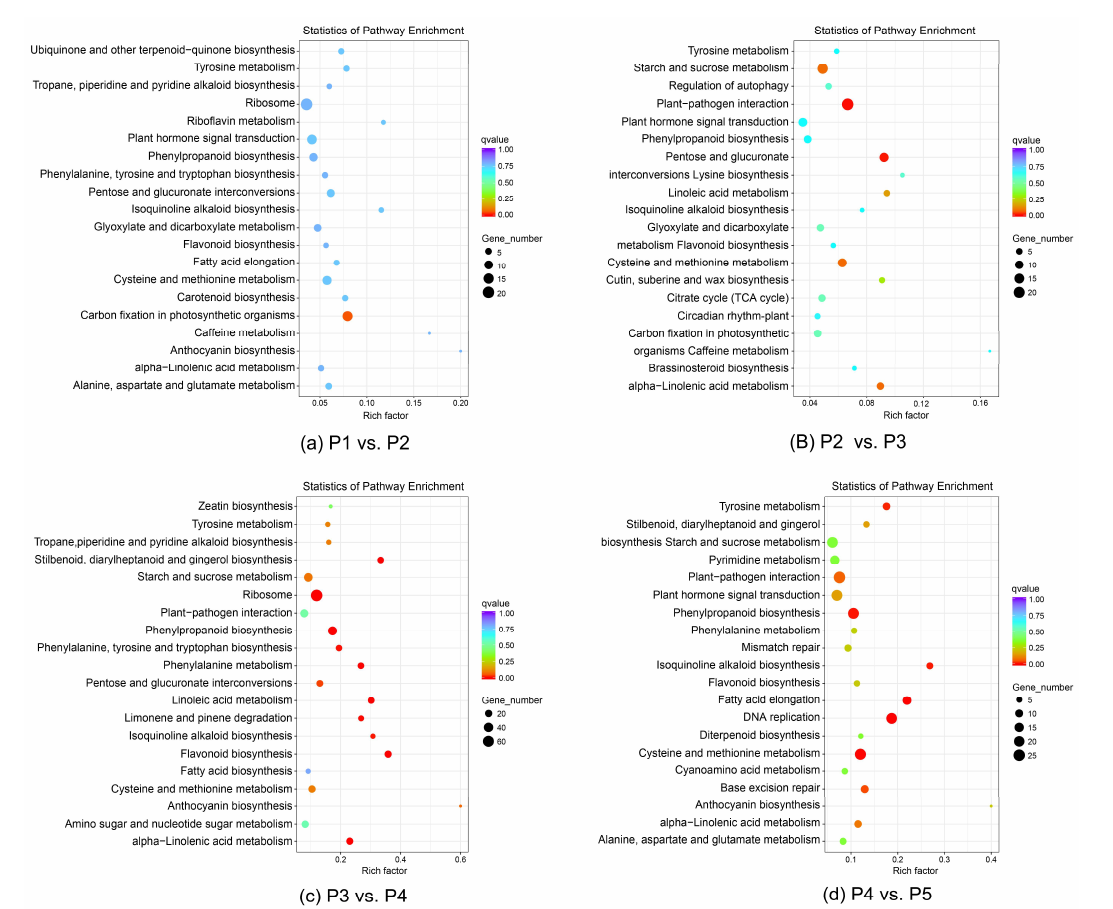
Figure 4. Top 20 enriched KEGG pathways for the DEGs in different comparisons. ( a − d ) the comparison of P1 vs. P2, P2 vs. P3, P3 vs. P4, and P4 vs. P5. P1 − P3: 1 − 3-year-old bulbs that cannot flower, P4 − P5: 4-year-old nonflowering and flowering bulbs. The vertical axis represents the names of the pathways, and the horizontal axis represents the Rich factor corresponding to the pathways. The q-value is represented by the color of the dot; the smaller the q-value, the closer the color is to red. The number of DEGs of each pathway is represented by the size of the